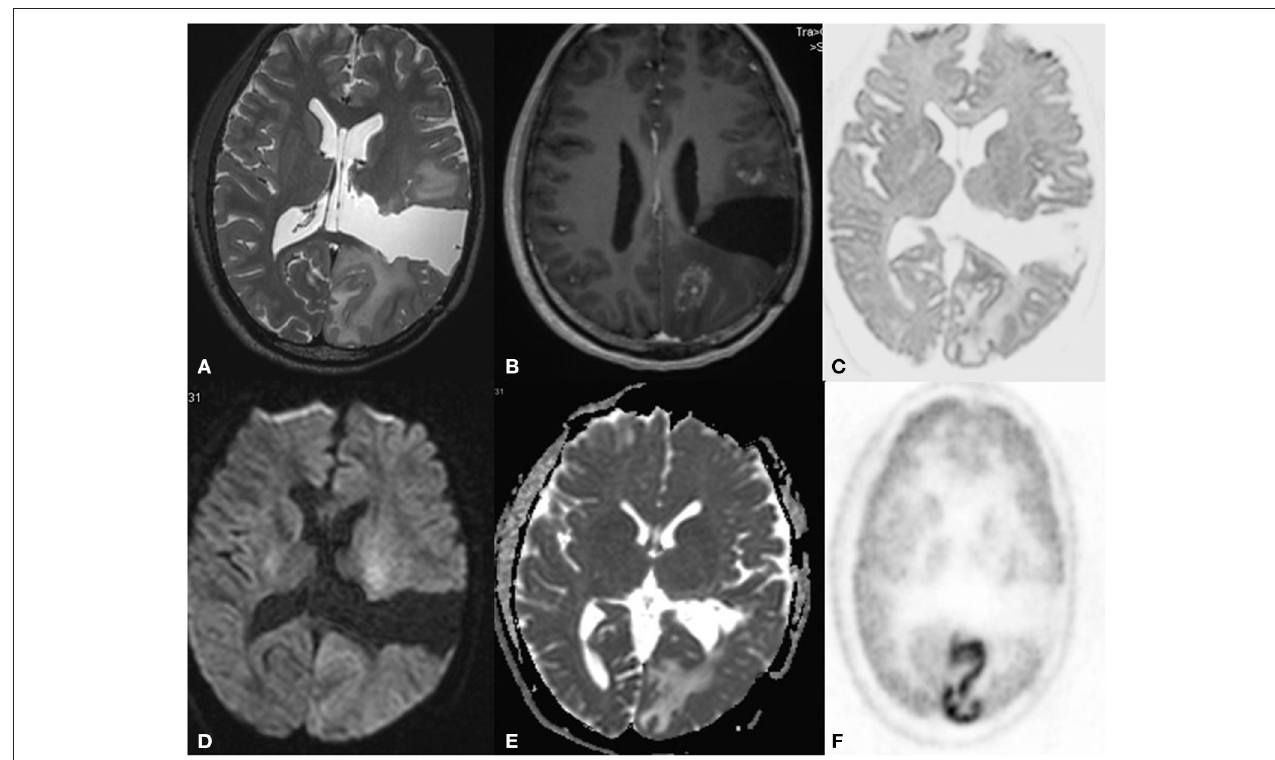
FIGURE 5 | A 32 year old male postoperative, post-radiotherapy case of Anaplastic mixed oligoastrocytoma left thalamus, 3 year follow up MRI FDG PET axial images T2W (A) post-contrast T1 (B) Inverted DWI (C) DWI b2000 (D) ADC (E) NAC PET (F) show a postoperative cavity in the left parietal region. Anterior and posterior to this there is a heterogeneously enhancing lesion with elevated perfusion. The lesion shows DWI restriction with hypermetabolism on PET. This is suggestive of recurrence, but there is a large area of gyral enhancement due to SMART Syndrome. There is a false positive uptake on